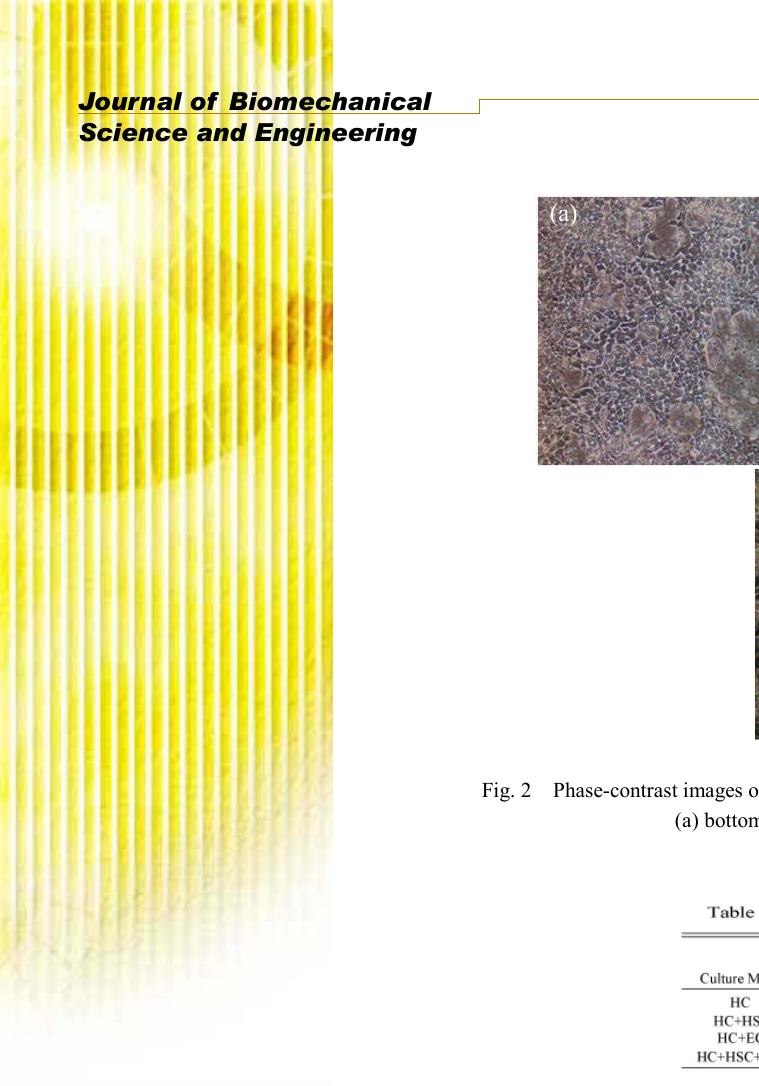
Data are presented as the means ± SD (N =